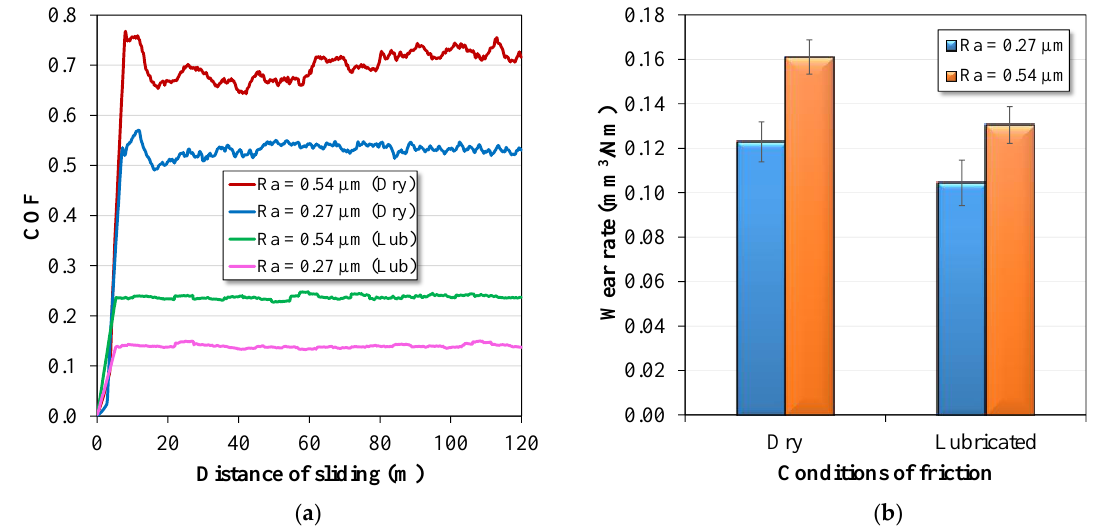
Figure 5. Experimental results of the PoD test. ( a ) COF and ( b ) wear rate.